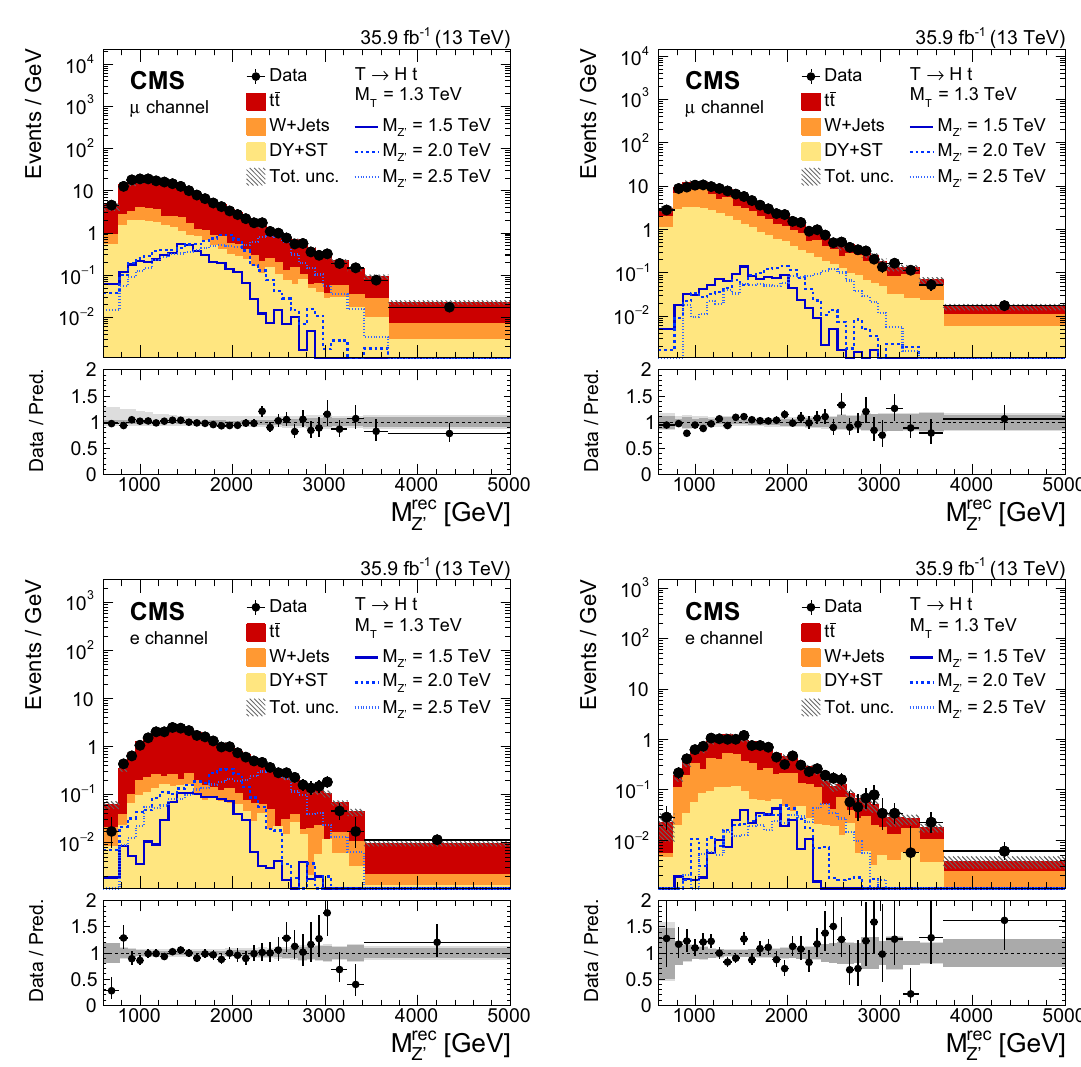
Fig. 4 Distribution of the reconstructed Z (cid:3) boson mass in the μ +jets channel (upper row) and e+jets channel (lower row) for the tt-enriched control region (left) and for the W+jets-enriched region (right). The expected signal distribution is shown for various M Z (cid:3) masses for a fixed mass M T = 1 . 3TeV in the T → Ht decay channel, each with a nominal